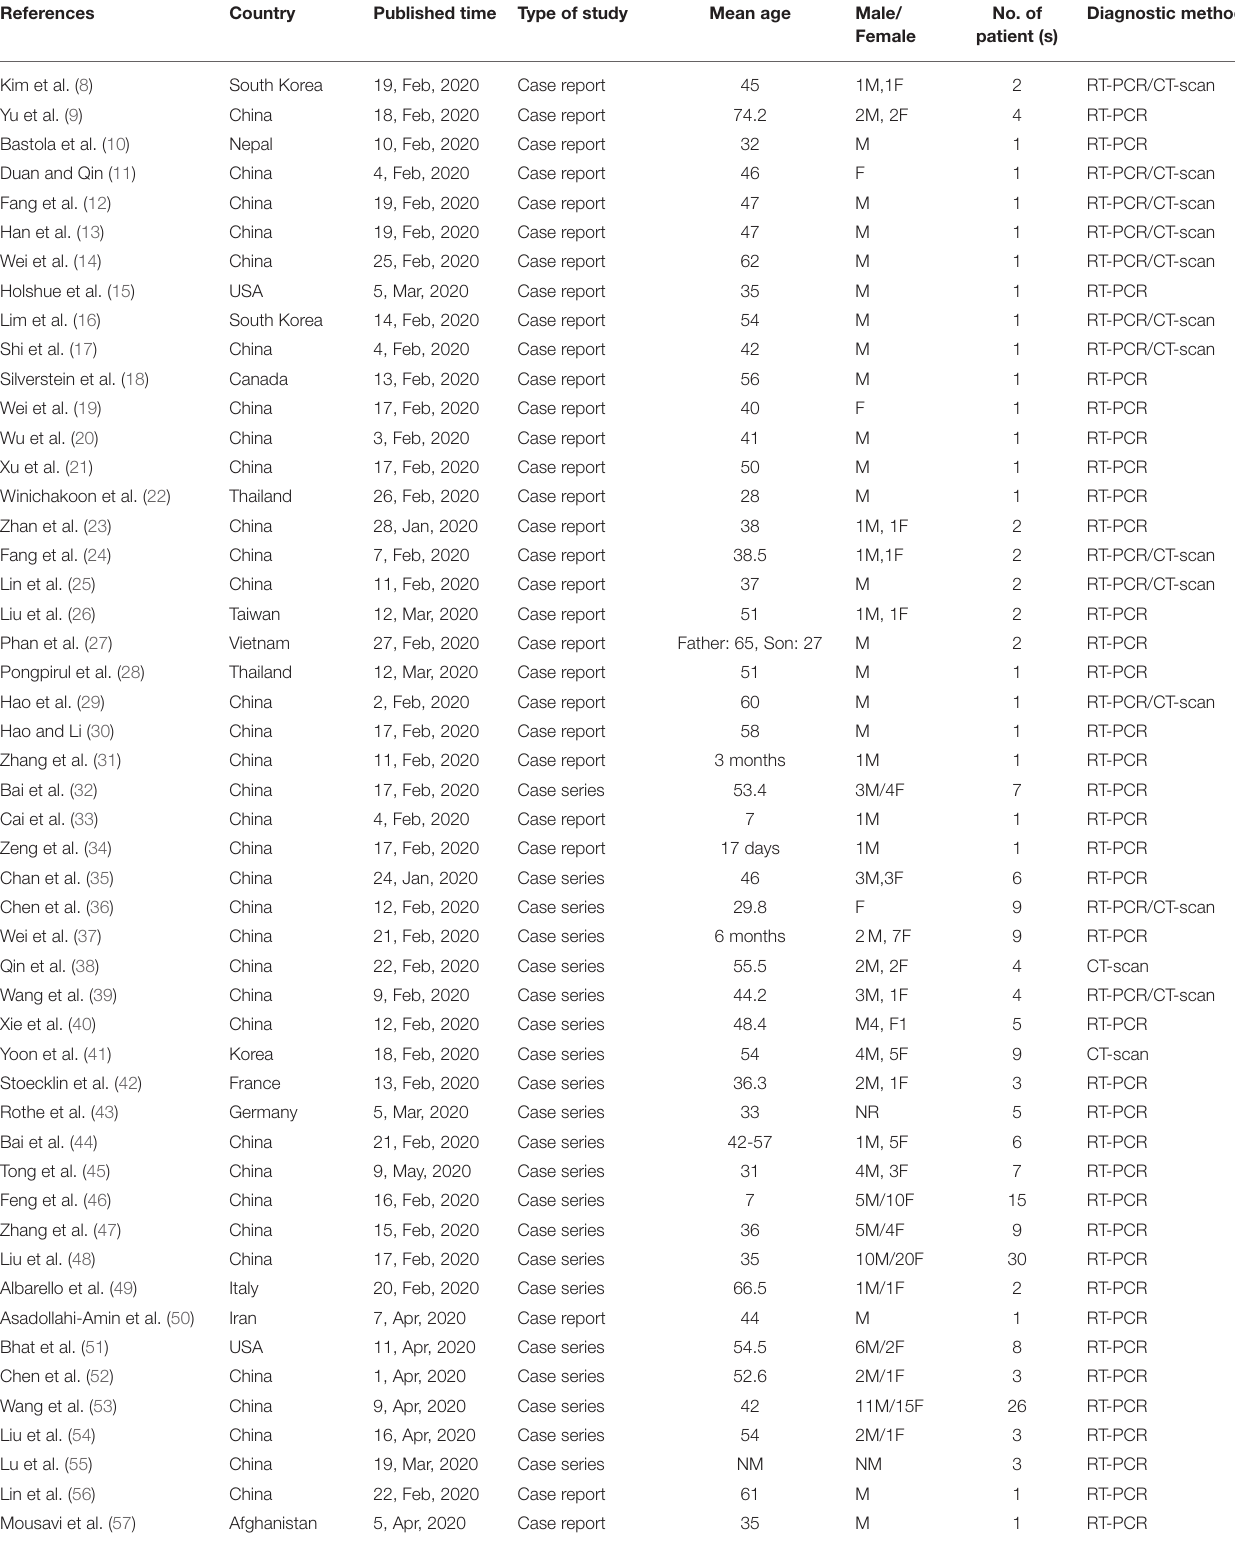
TABLE 1 | Characteristics of the included